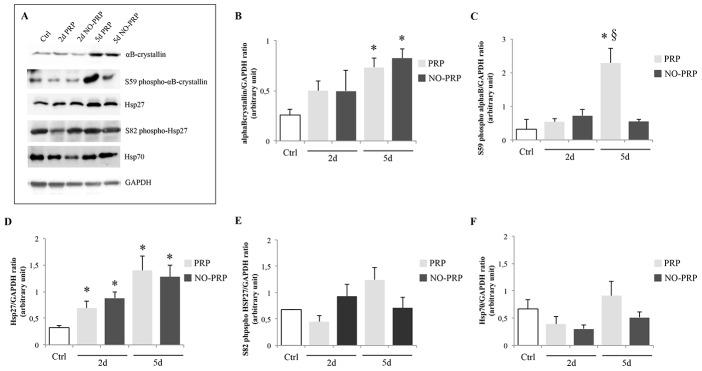
Effect of PRP treatment on several HSPs during regeneration process (2- and 5-day post-injury).(A) Representative immunoblot of each protein marker reported. (B) αB-crystallin; (C) S59 phospho-αB-crystallin; (D) Hsp27; (E) S82 phpspho-Hsp27; (F) Hsp70. Each bar represents mean value ± SEM (n = 5/group at each point). * p<0.05 vs. Ctrl group.§ p<0.05 vs. 5d NO-PRP group.